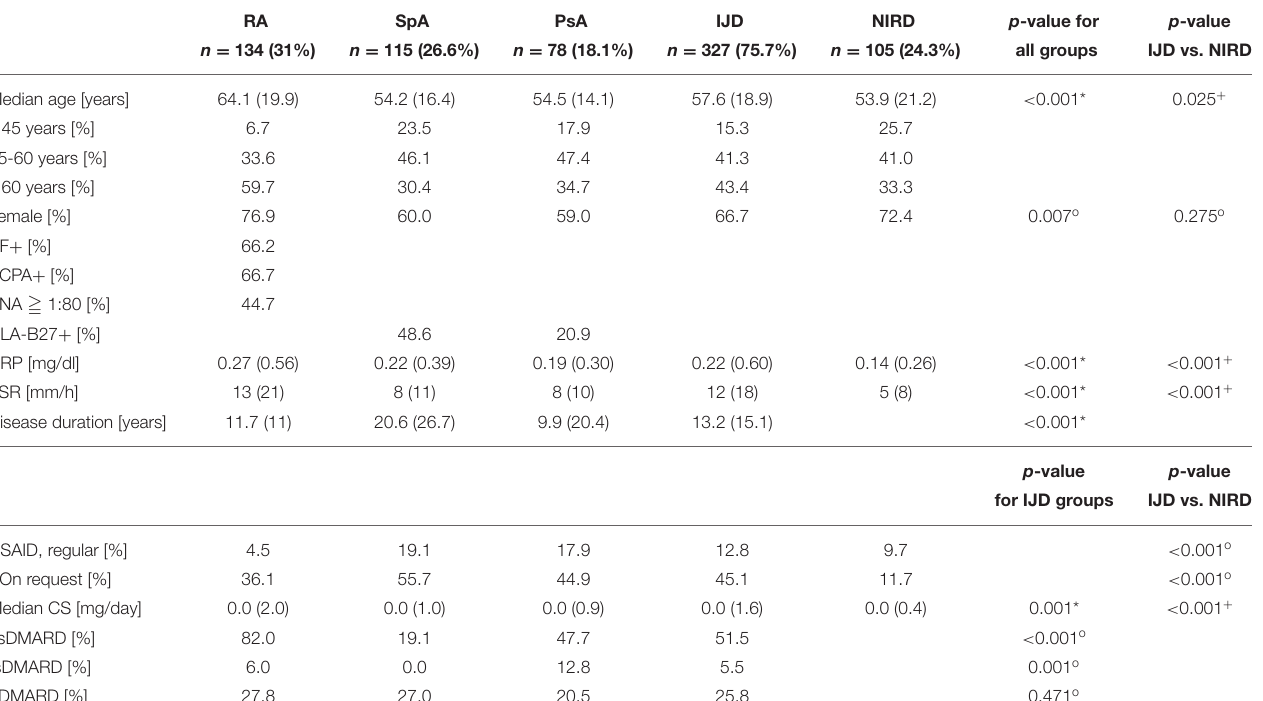
TABLE 3 | Patient’s and disease’s